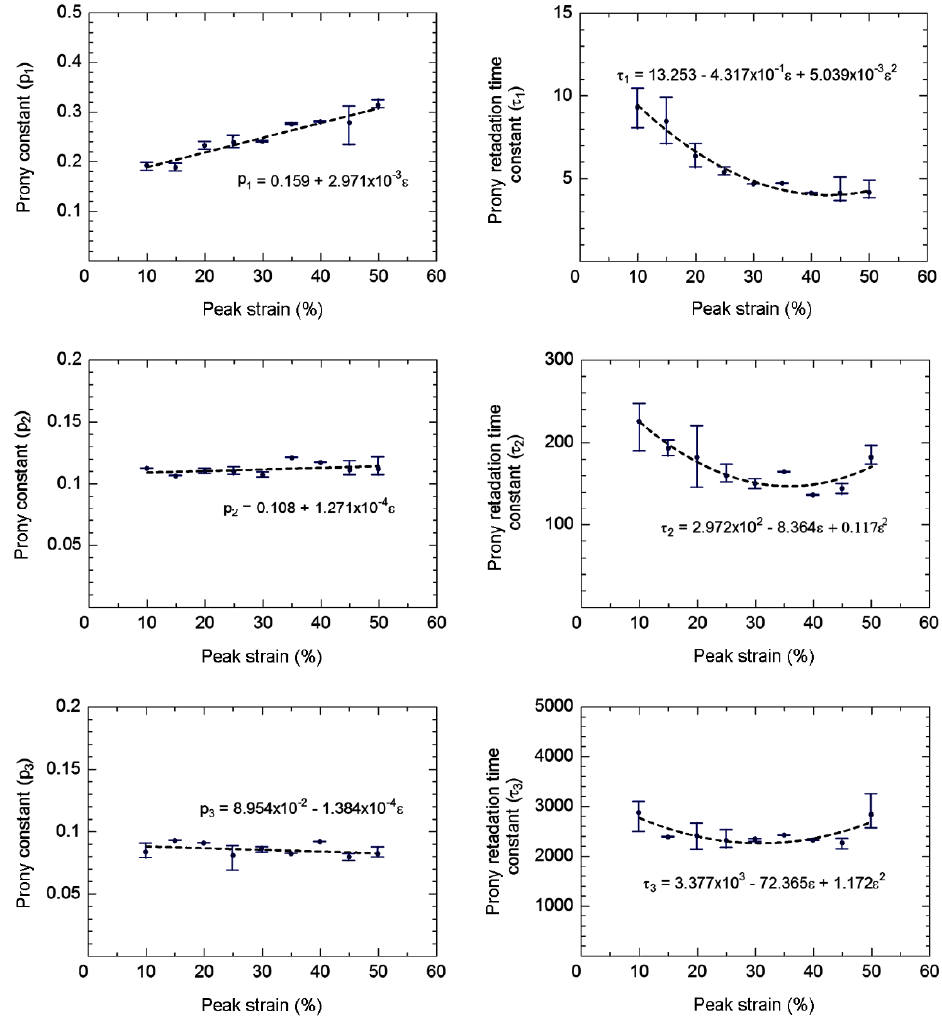
Figure 9. Estimated viscoelastic parameter vs. peak strain of disc-A.